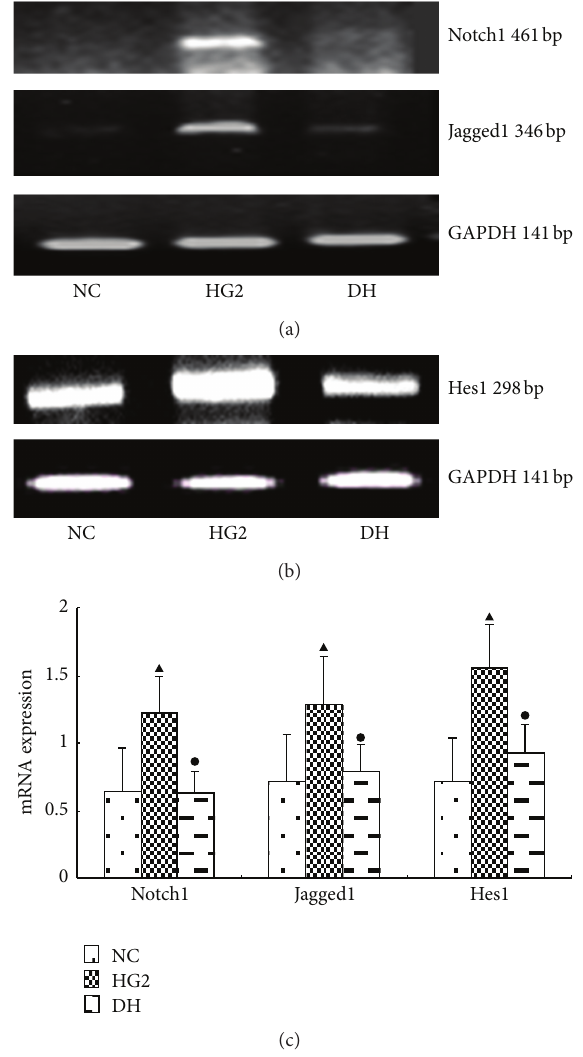
Figure 6: The expression of Notch pathway components after intervention with DAPT determined using PCR for 12h. (a) RT- PCR strip chart for Notch1 and Jagged1. (b) RT-PCR strip chart for Hes1. (c) The gray graph shows the relative statistical values for Notch pathway components in each group. Compared with the NC group, the expression of the Notch pathway components mRNA was significantly increased in the HG2 group. After DAPT intervention, the mRNA expression of Notch pathway components decreased. 󳵳 𝑃 < 0.05 versus NC group; ∙ 𝑃 < 0.05 versus HG2 group.